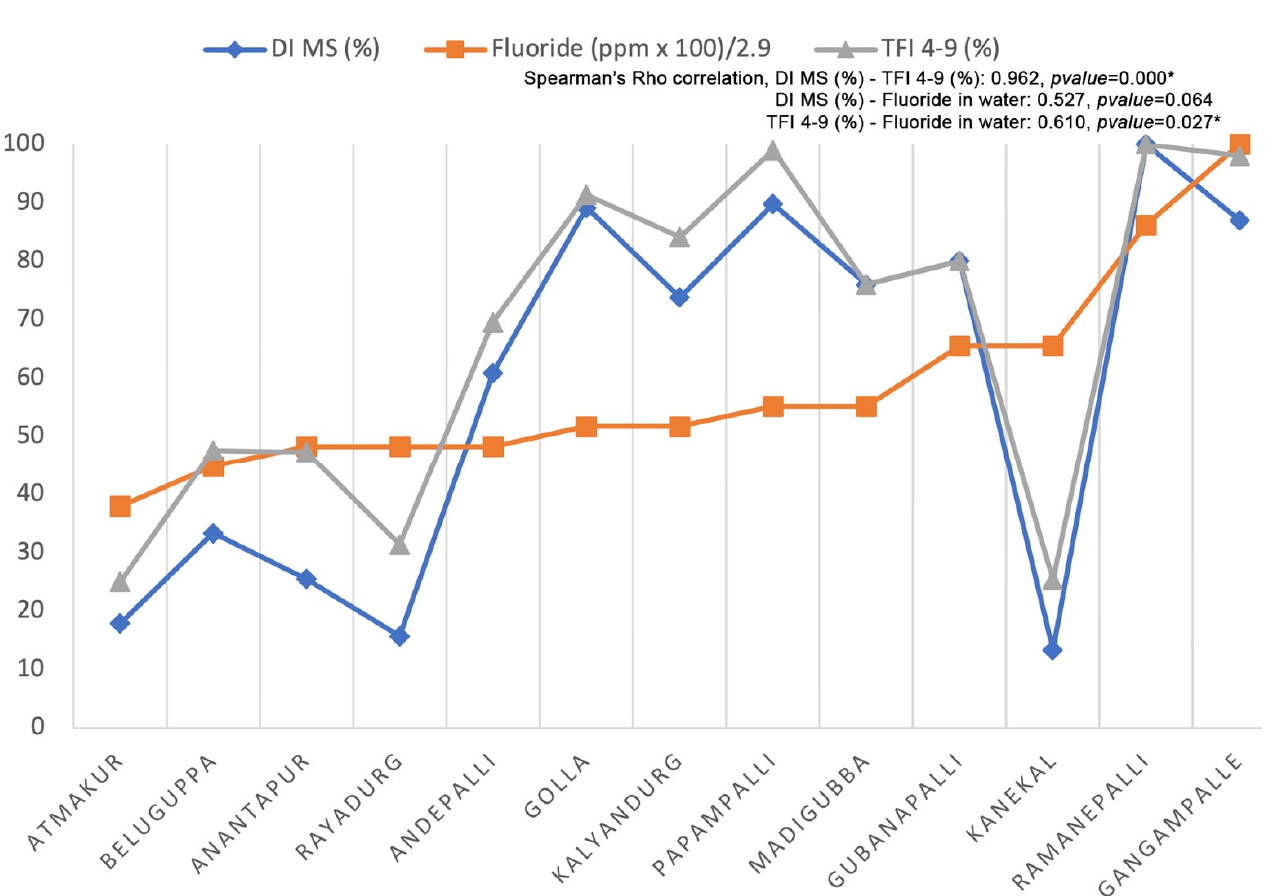
Figure 3. Spearman’s Rho correlation considering fluoride concentration found in water samples obtained in each community included in the study and the percentage of cases considered MS by DI and 4–9 by TFI observed in each community. The major value of fluoride observed in drinking water is 2.9. * Significant correlation.